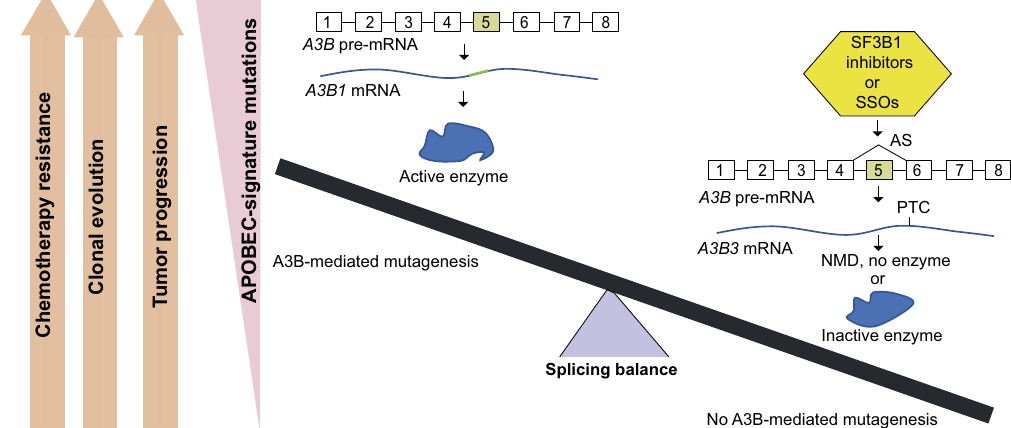
Fig. 8 The proposed model to target alternative splicing of A3B for modulating APOBEC mutagenesis. Canonical splicing of A3B pre-mRNA generates the mutagenic A3B1 enzyme that causes APOBEC mutagenesis and fuels tumor progression, recurrence, clonal evolution, and chemotherapy resistance. Alternative splicing of A3B , and, speci fi cally, skipping of exon 5, generates A3B3 isoform with a premature termination codon (PTC). Some of this aberrant transcript is degraded by nonsense-mediated decay (NMD), and the residual transcript encodes catalytically inactive protein isoform. Therapeutic enhancing of exon 5 skipping by SF3B1 inhibitors or other tools affecting alternative splicing, such as splicing-switching oligonucleotides (SSOs), may restrict and even prevent A3B-mediated mutagenesis in clinically relevant